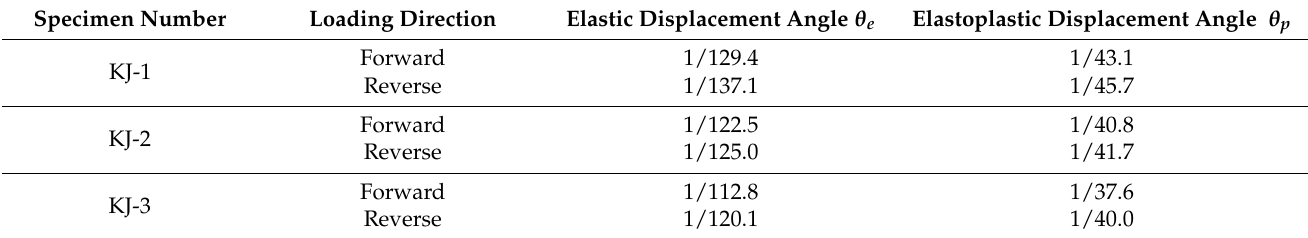
Table 10. Yield displacement angle of displacement for the